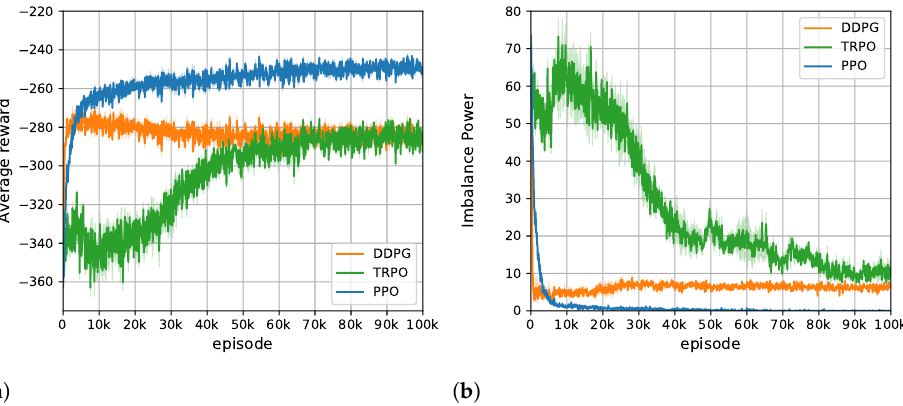
Figure 6. Training performance of DDPG, TRPO, and the proposed approach (PPO). ( a ) Mean and 95% confidence interval of episode reward over five random runs; ( b ) Mean and 95% confidence interval of imbalance power over five random runs.